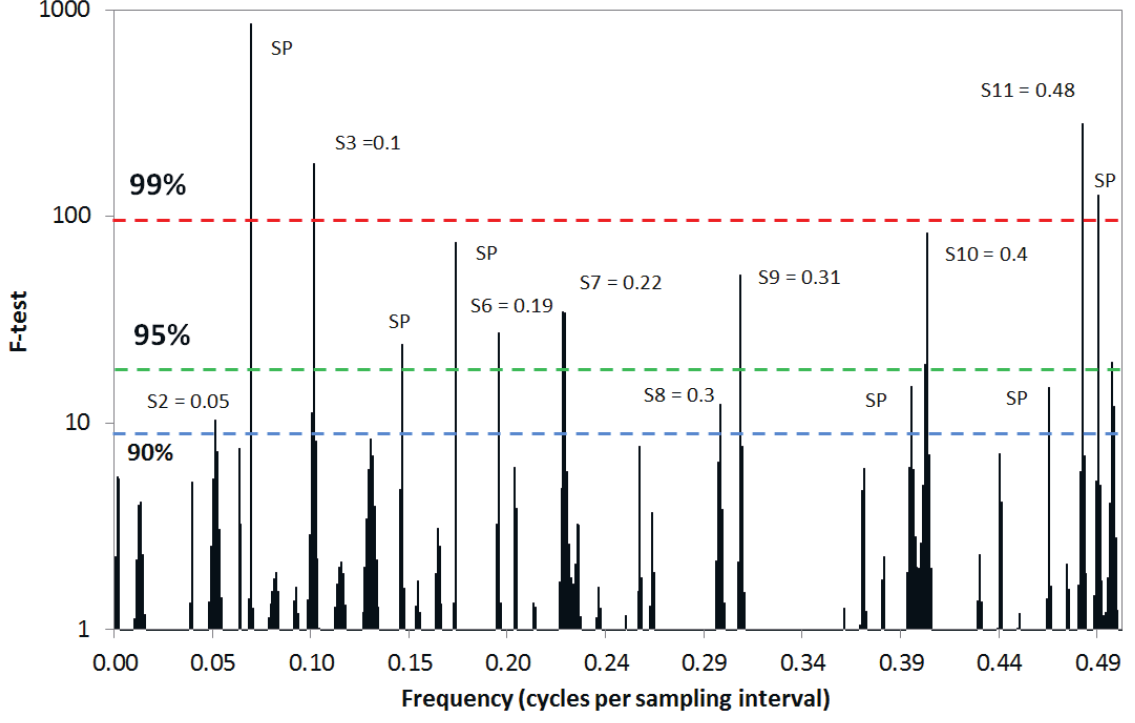
Figure 5. Statistical confidence levels of the power spectrum shown in Figure 4, calculated by the F -test associated with the Thomson multitaper estimator. The Nyquist frequency is 0.5 which corresponds to a period of 2 arbitrary units of time.